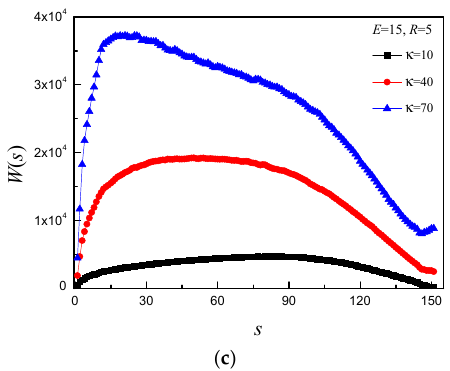
Figure 9. The waiting time distribution W ( s ) as a function of monomer s for N = 150 and different κ under: ( a ) E = 1.5; ( b ) E = 5; and ( c ) E = 15. Here, R = 5. Figure 10 shows that the W ( s ) has the same changing trend for R = 3, however, the position of peak or cusp shifts to s = 9. It indicates that the R has effect on the position of peak or cusp. The position of peak indicates that the subchain of the trans side just touches the right flat membrane. In order to let the monomers translocate into the trans side, the subchain must stretch itself in x – y plane. When E is small, the resisting force is so small that the subchain on the trans side needs lots of time to adjust its position to bend itself and stretch itself in x – y plane. The larger κ is, the more rigid the chain is. Therefore, the adjustment time is longer for larger κ . That is why there is a peak for large κ , and the peak becomes steeper and steeper with increase of κ at small E . When E is large, the resisting force is so large that subchain of the trans side does not need to adjust its position to bend and extend itself in x – y plane. That is why there is cusp for large κ and E.